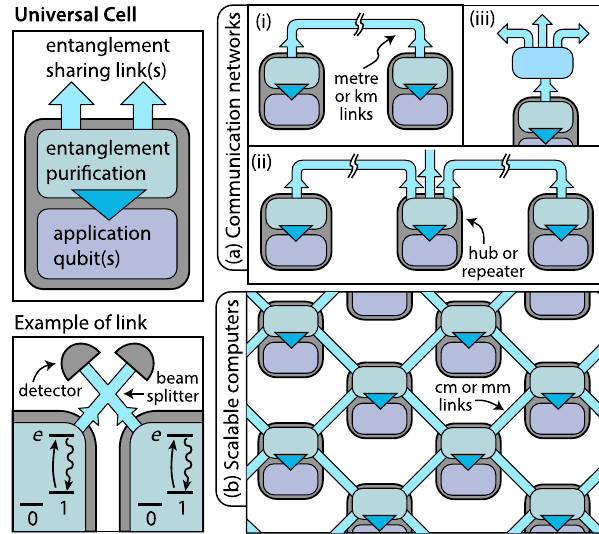
FIG. 1. A small, well-controlled quantum system interfaced to a noisy entanglement-sharing channel constitutes a universal cell if it can purify the entanglement to a high fidelity. Such cells enable secure communication; monogamy of entanglement [12] means the links need not be secure and may be either direct (i) or via repeater hubs (ii) or switches (iii). (b) Moreover, a dense array of cells bridged by short links constitutes a freely scalable computer, as we analyze